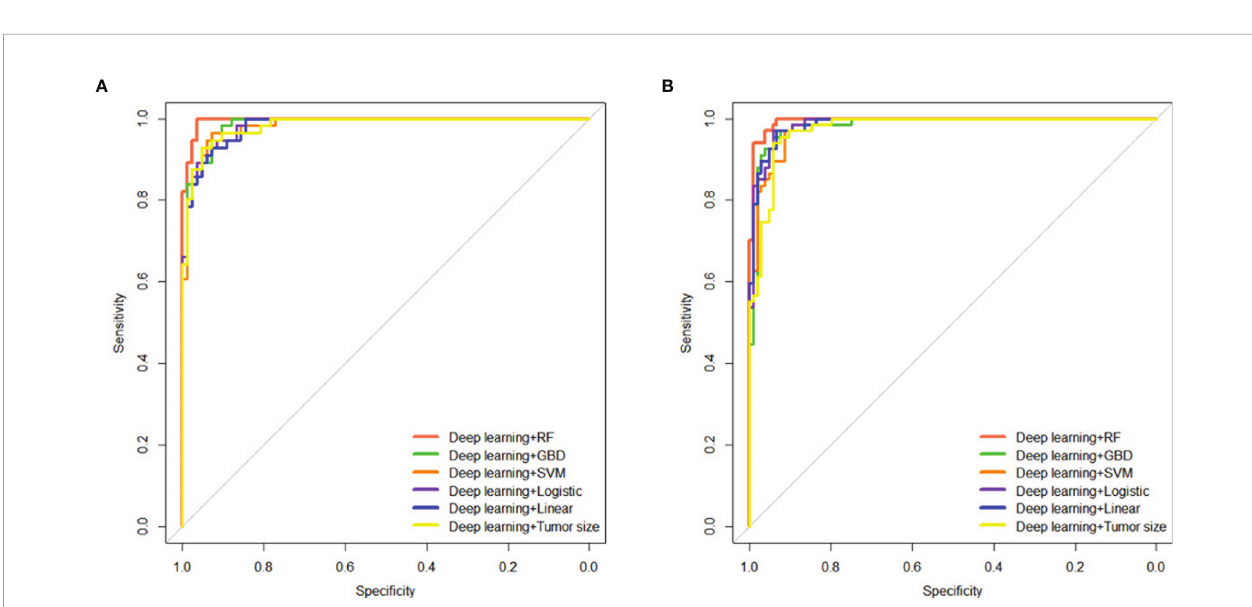
FIGURE 4 | Correlation between tumor size, cML, and DL. Evaluating the mutual correlation between tumor size, the fi ve radiomics cML models, and the DL model via correlation heatmaps in the training (A) and validation (B) cohorts. cML, conventional machine learning; DL, deep learning.